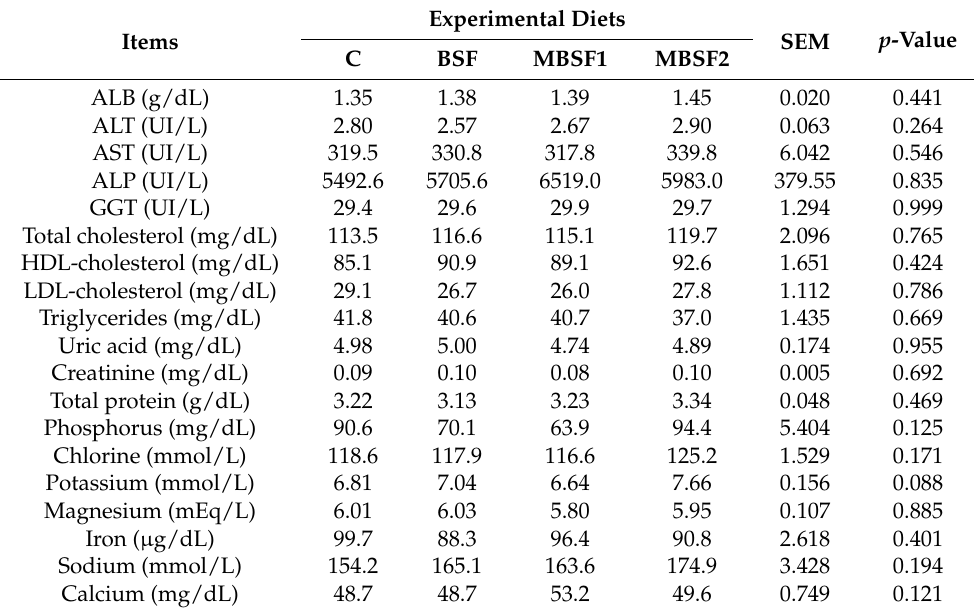
Table 4. Effect of black soldier fly larvae fat on blood traits of broiler chickens (n =